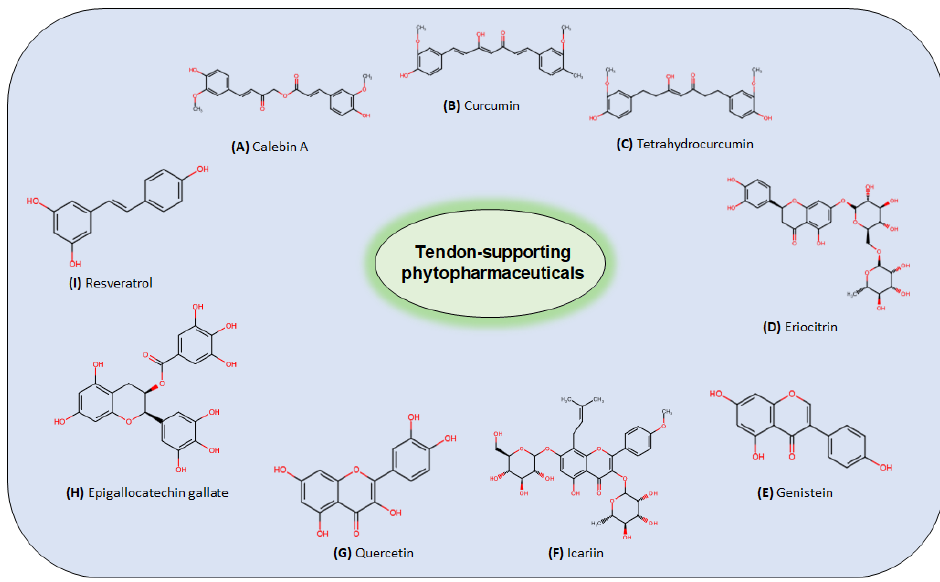
Figure 4. Chemical structures of tendon-supporting phytopharmaceuticals: curcuminoids ( A – C ), flavones/flavonoids ( D – G ), green tea extracts ( H ), and resveratrol ( I flavones/flavonoids ( D – G ), green tea extracts ( H ), and resveratrol (I ).